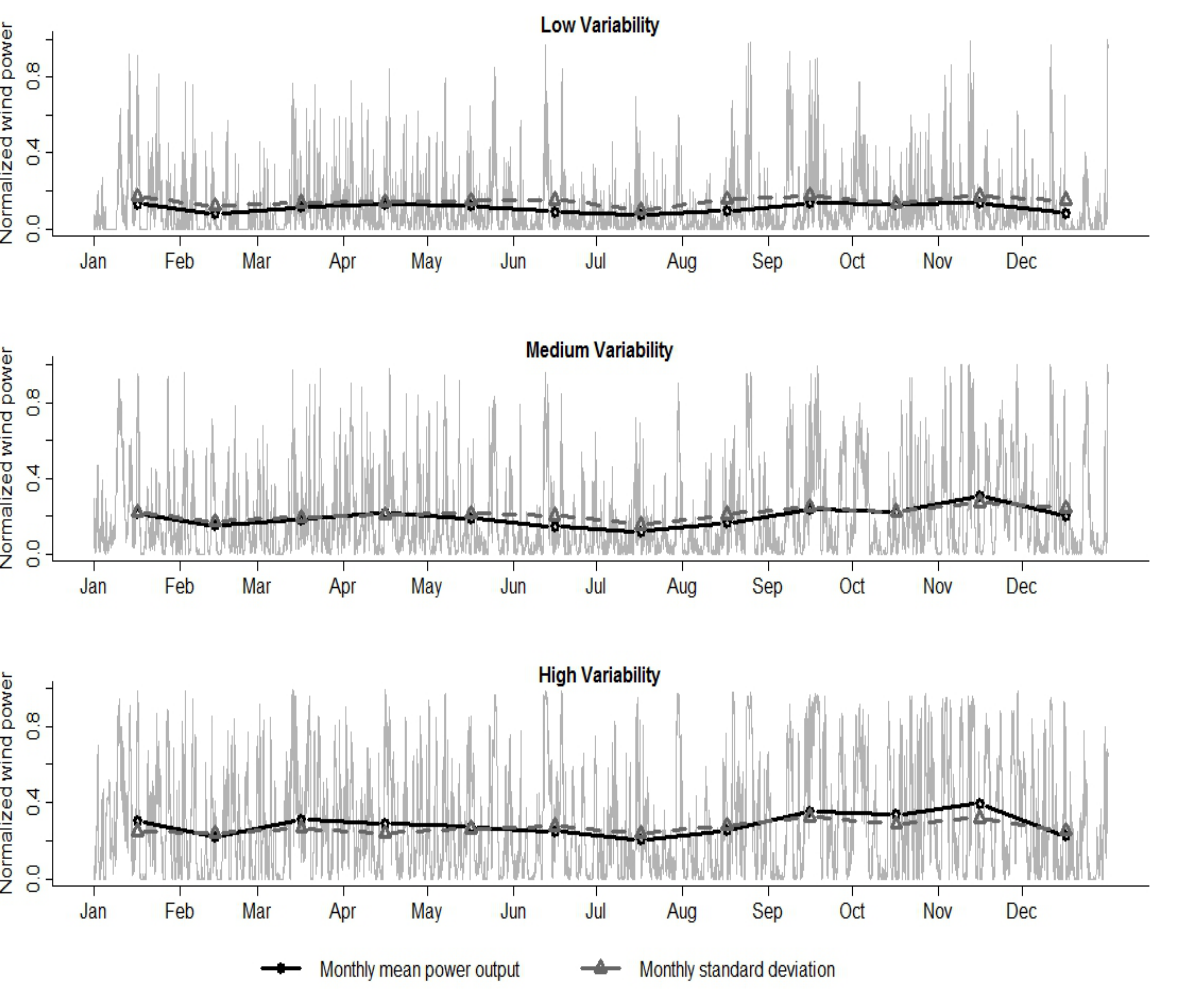
Figure 1. Time series plots of normalized power data for the three chosen Danish wind farms, for the year 2010. Please note that the point on the time axis labelled Jan refers to 00:00 on 1 January and similarly for every